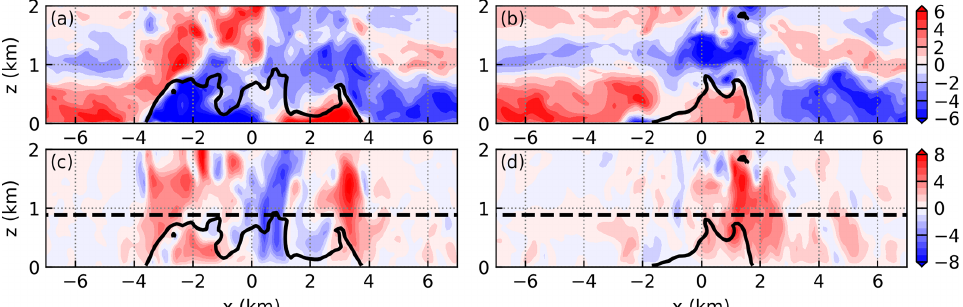
Figure 15. Vertical cross section of (a) cross-coast wind and (c) vertical velocity at y = 6 . 55km. Panels (b) and (d) are the same as (a) and (c) except at y = 0 . 75km. The black contour indicates the edge of the cold pool. The dashed line indicates the LFC. The results are at t = 8h 17min of simulation THF700.